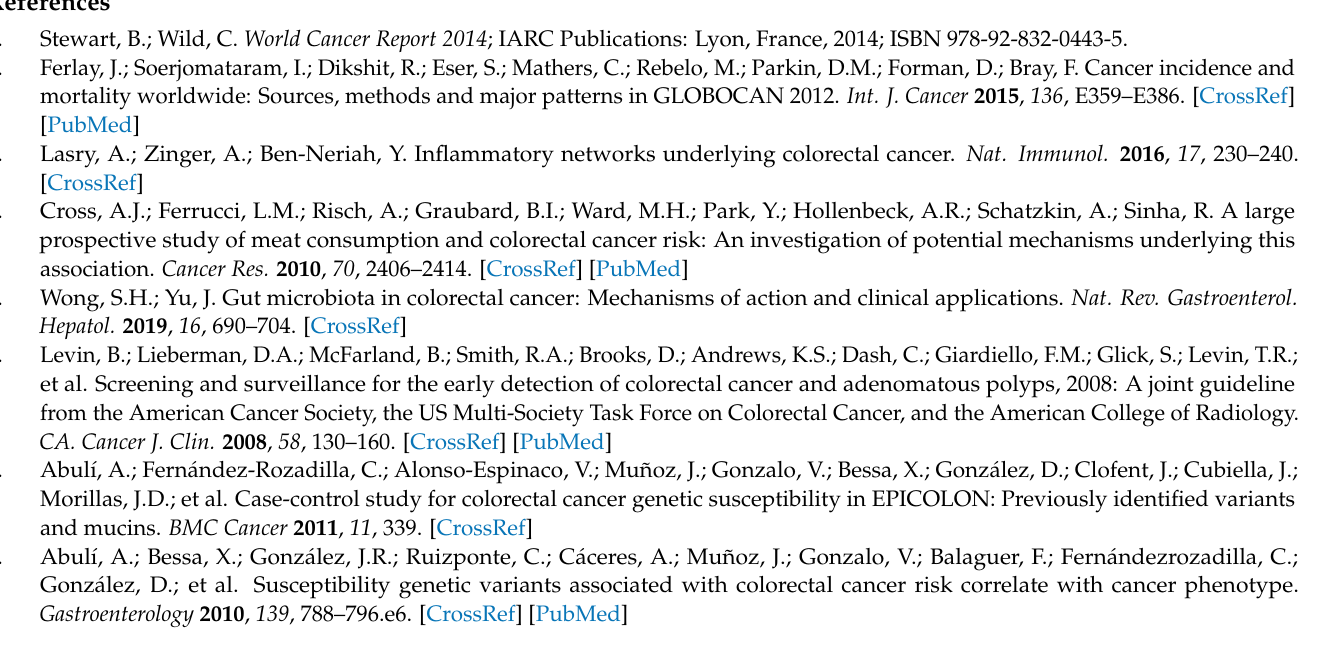
cohort; Table S1: Results of SNPs previously associated with CRC; Supplementary Table S2: Sensitivity analyses of used instruments in Mendelian Randomization analyses; Supplementary Table S3: Results of Mendelian Randomization analyses using modifiable risk factors as exposures; Supplementary Table S4: Results of Mendelian Randomization analyses using bacterial phyla as